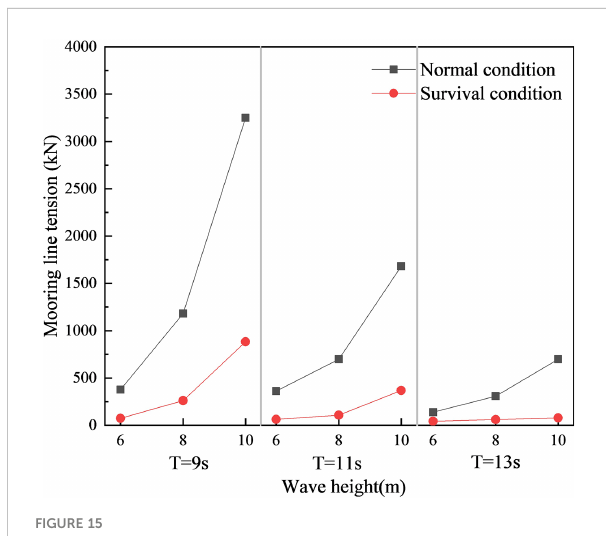
FIGURE 15 Mooring line tension comparison of fi sh farm platform under different operating